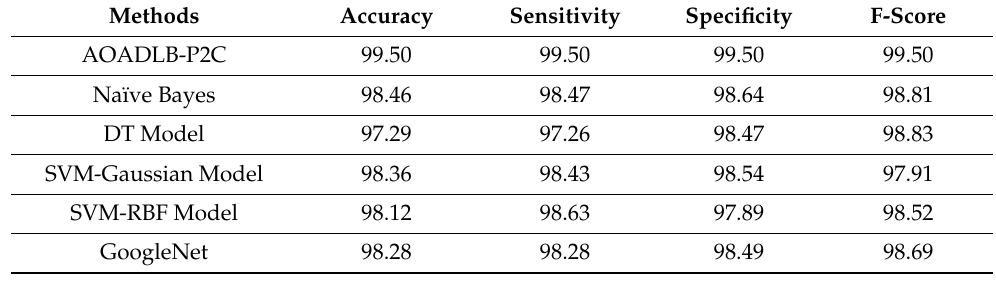
Table 3. Comparative analytical results of the proposed AOADLB-P2C system and other recent approaches.